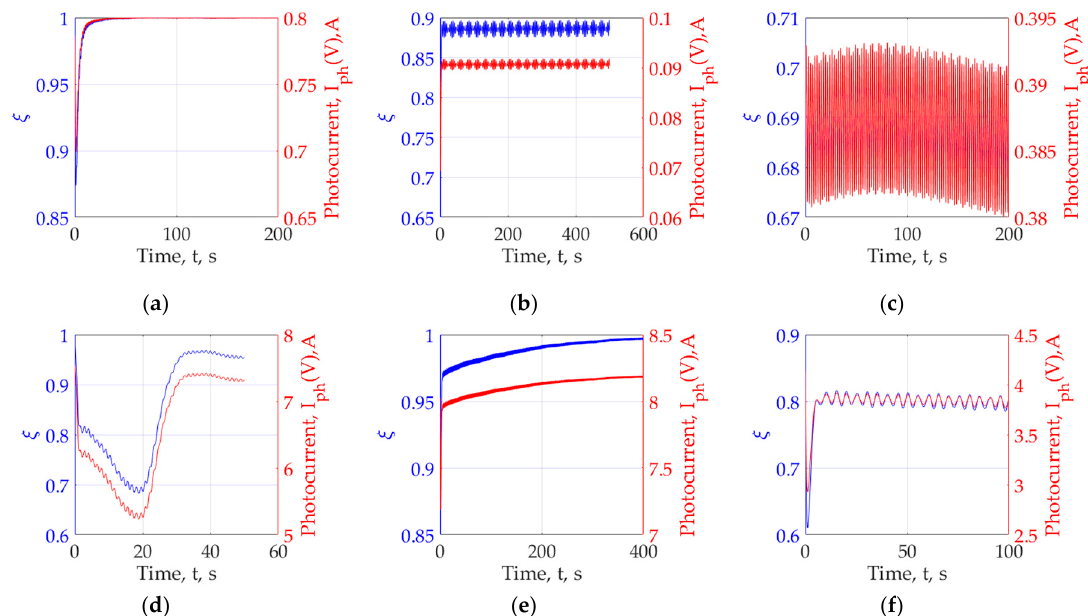
Figure 16. Comparison of photocurrent amplitudes and incidence coefficient ξ for various experiments (No. 1–6). ( a ) Experiment No.1, ( b ) Experiment No.2, ( c ) Experiment No.3, ( d ) Experiment No.4, ( e ) Experiment No.5, ( f ) Experiment No.6.